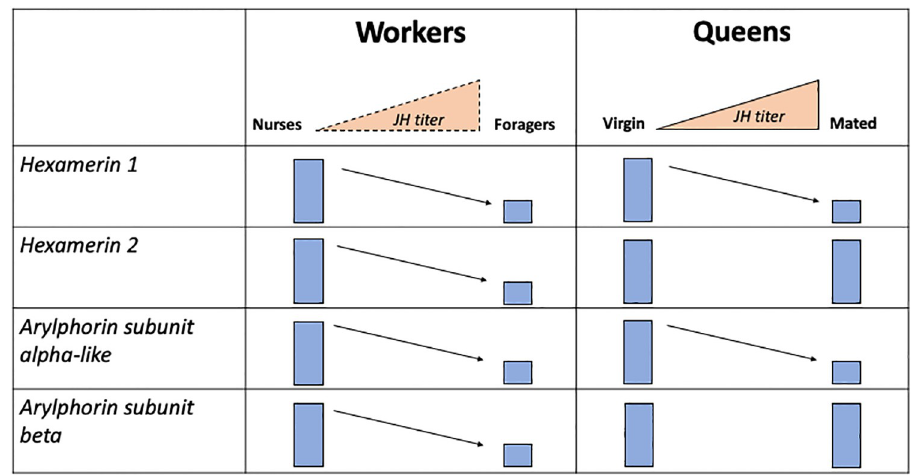
Fig 6. Proposed two modules regulating hexamerin expression in S . invicta : queens and workers. In workers, hexamerin expression is regulated by JH. The expression of the four hexamerins decreases as workers transition from nursing to foraging tasks, which supports the existence of changes in JH as the workers age (represented in dashed). In queens, only hexamerin 1 and arylphorin subunit alpha-like are regulated by JH. Both genes are down-regulated in mated queens compared to virgin